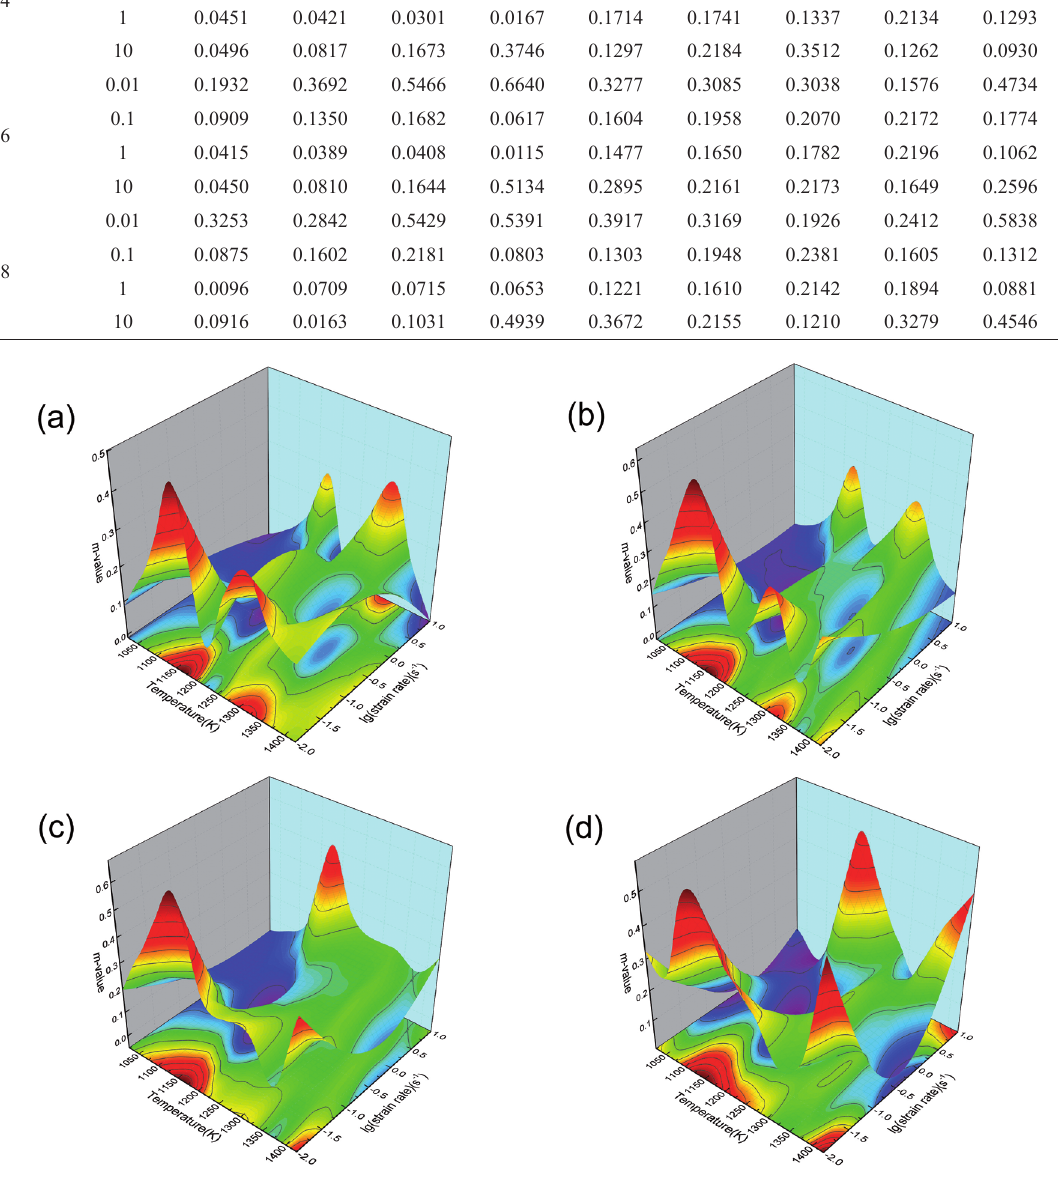
Figure 7: The 3D response surface of m -value on strain rate and temperature under different strains: (a) ε=0.2, (b) ε=0.4, (c) ε=0.6 and (d)